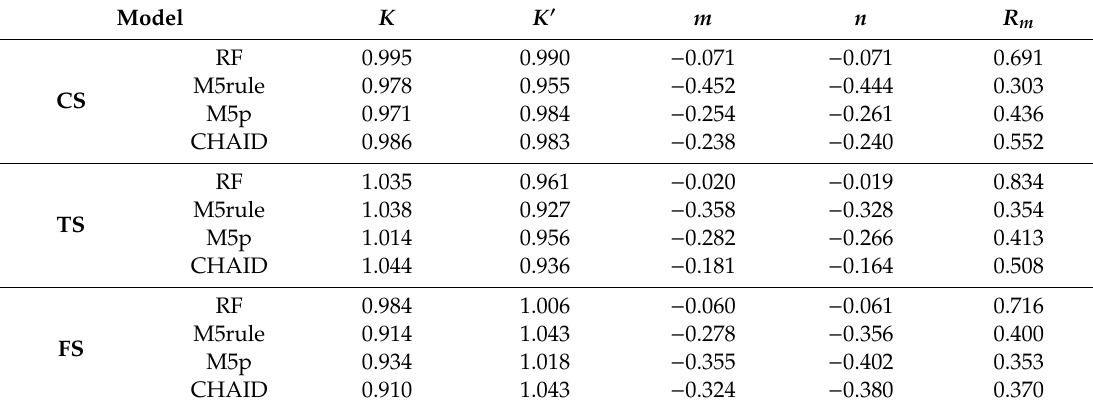
Table 6. Statistical measures of explained variance (EV) for all proposed